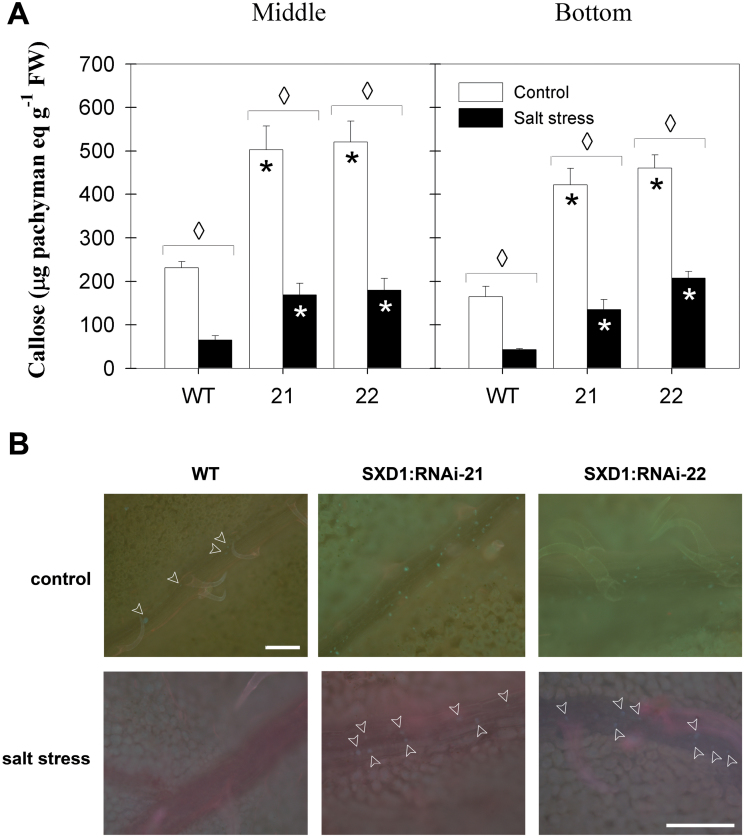
Callose content and tissue distribution in source leaves of StSXD1-silenced potato plants 19 days after the onset of salt treatment. (A) Callose content in middle (leaf 8, left panel) and bottom (leaf 11, right panel) leaves of control (white bars) and salt-treated (black bars) plants. Data are given as β-1,3-glucan pachyman equivalents and represent the mean ± SE of four individual plants. Data were analysed by t-test; significant differences between the transgenic lines and the wild type (WT) within a treatment are indicated by a black asterisk (control treatment) or a white asterisk (stress treatment), while diamonds indicate significant differences between control and salt stress within a genotype (P < 0.05). (B) Fluorescence microscope images of potato middle leaves stained with aniline blue, showing class II and III veins and surrounding mesophyll in the wild type (WT) (left images), SXD:RNAi-21 line (middle images), and SXD:RNAi-22 line (right images). Upper images, control treatment; lower images, salt-stress treatment. Callose was observed in both tocopherol-deficient potato lines as bright spots along the phloem, mainly in control conditions. Arrowheads indicating callose appositions have been included in some images for the sake of clarity. Images are representative of four individual plants per genotype and treatment. The bar in the bottom right image represents 100 μm for all panels except for the top left image, which bears its own reference bar of 100 µm.